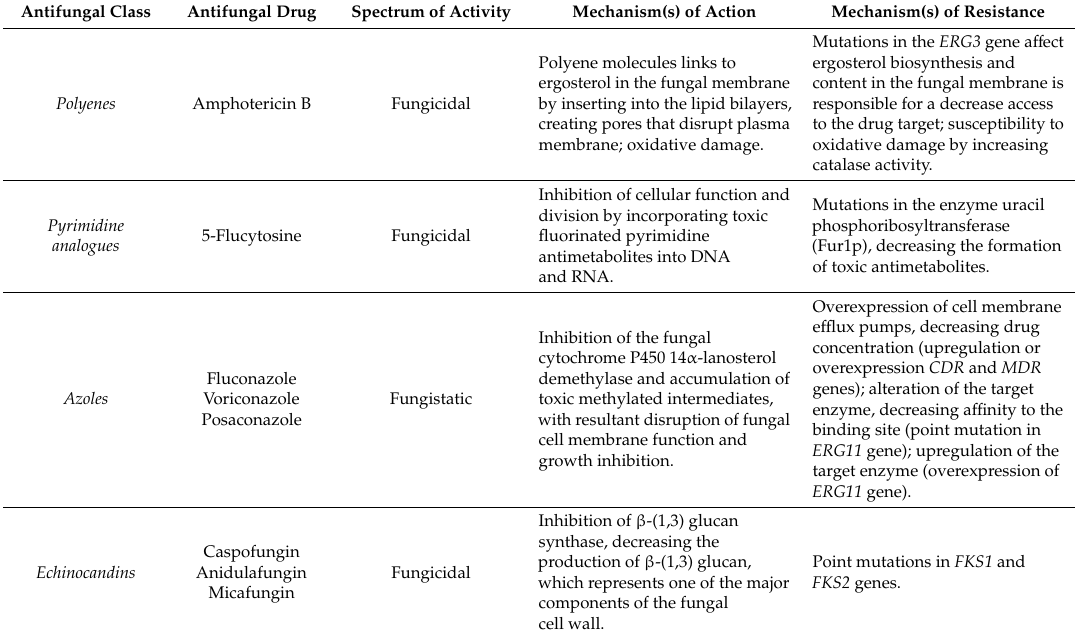
Table 1. Spectrum of activity and mechanisms of action and resistance of the major antifungal agents enrolled in the treatment of invasive